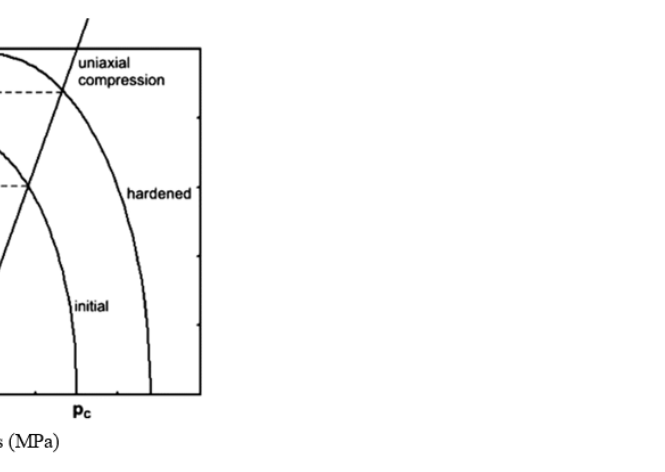
Figure 2. Exemplary sections of the initial and a hardened yield surface for the crushable foam, in the plane containing the hydrostatic stress axis.